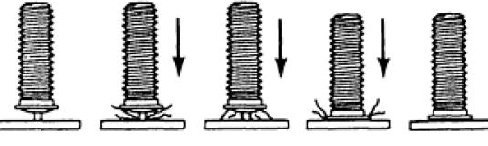
Figure 2. Stages of arc stud welding [3].